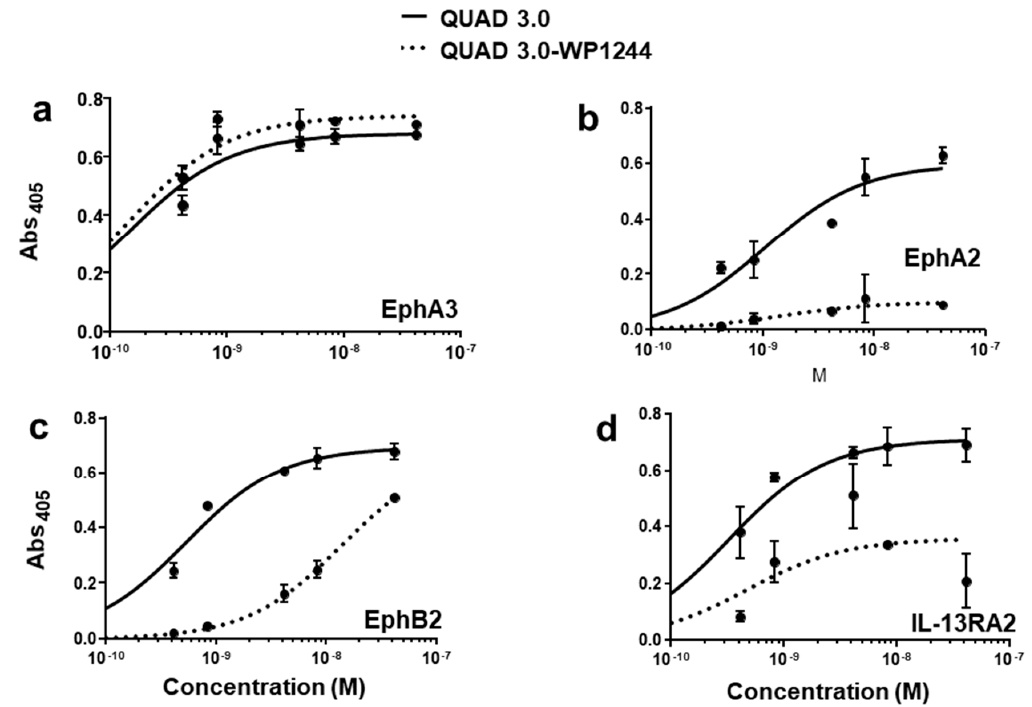
Figure 4. QUAD 3.0 Dox 1244 binding to EphA3, EphA2, EphB2, and IL-13RA2 receptors. ELISA results showing the binding of unconjugated QUAD 3.0 and QUAD 3.0-WP1244 conjugate to ( a ) EphA3; ( b ) EphA2; ( c ) EphB2; and ( d ) IL-13RA2 receptor proteins.